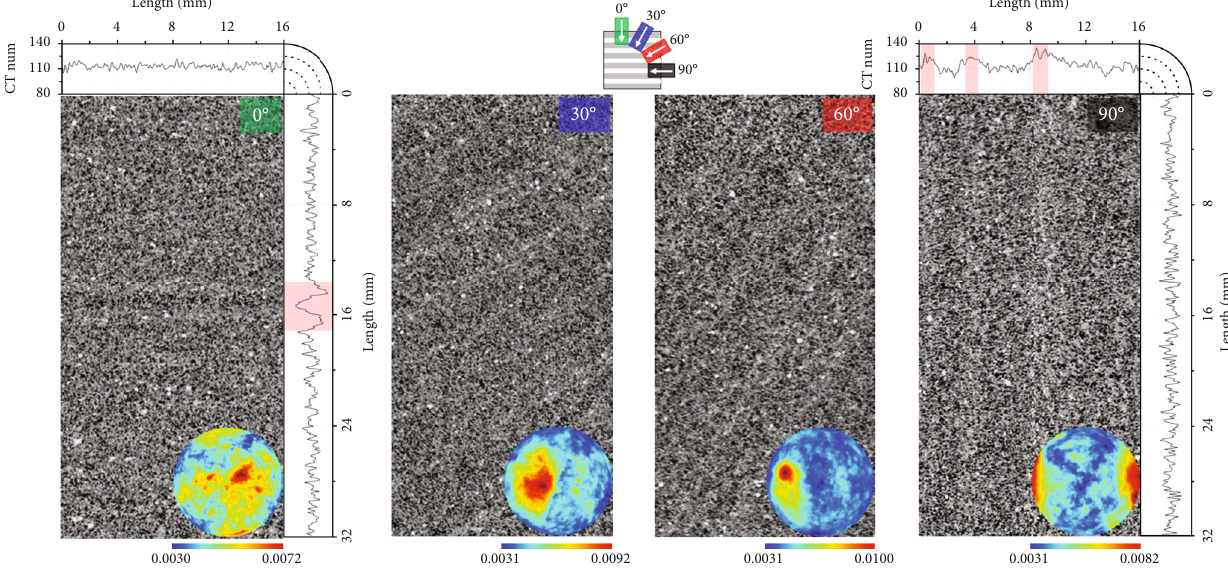
Figure 1: X-ray CT images and results of slicing plane method (SPM) with the coring direction from 0 o to 90 o of Berea sandstone. Note that CT number is the average value of orthogonal pixels to the length and the red part in SPM result presents the pole to the bedding